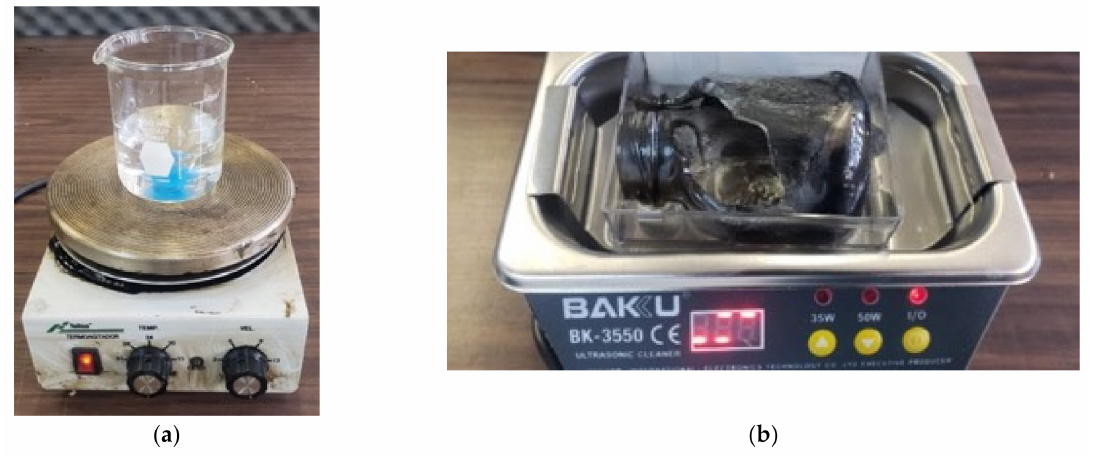
Figure 9. ( a ) Dispersion of nanoparticles, ( b ) ultrasonic bath